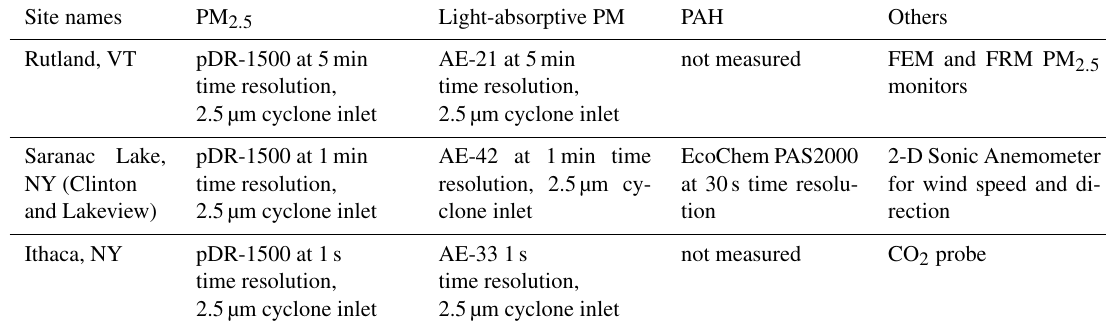
Table 2. Descriptions of air quality instruments deployed in various field